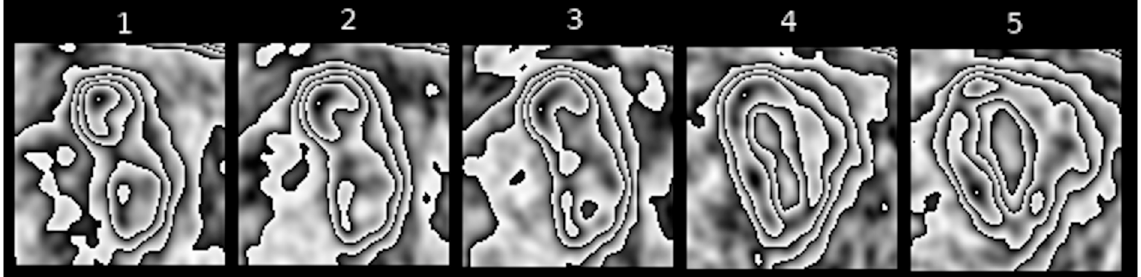
Figure 5. Example of a sequence of transformed PET images of a pulmonary nodule with considerably altered shape of [18F] FDG uptake contours.